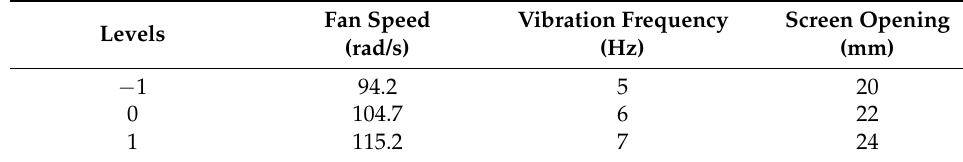
Table 2. Levels of each experimental factor.